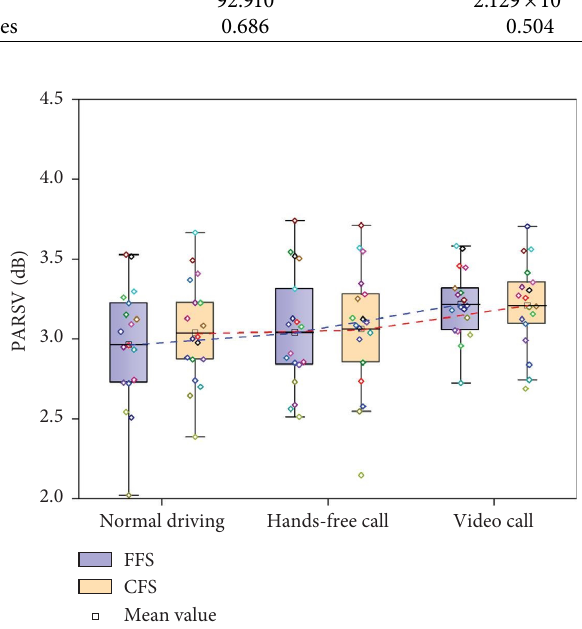
Figure 6: Comparison of drivers’ PARSV for each driving state in diferent trafc conditions. Table 7: One-way ANOVA of the infuence of driving state on PARSV.